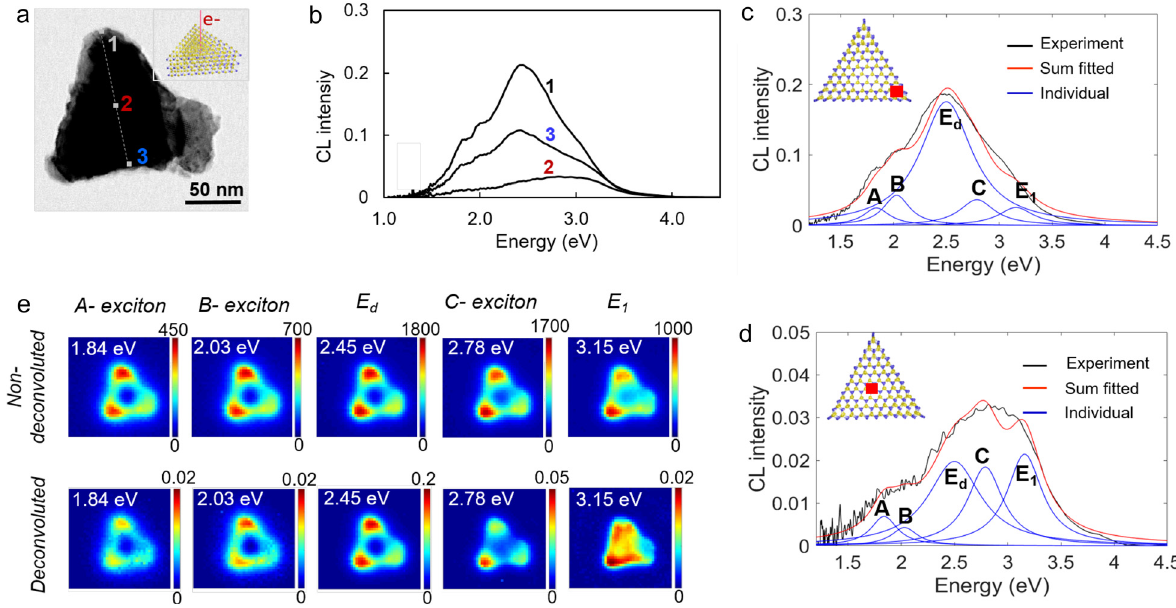
Figure 2: Mode analysis of triangular